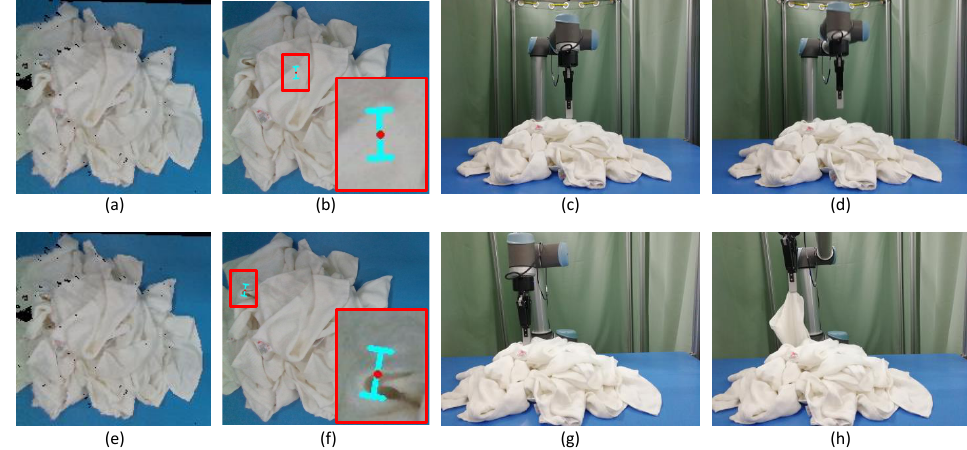
Figure 13. The comparison of the highest point and our method: ( a ) the point clouds of the white square towels on a table; ( b ) the projection of a grasp pose on the image with the highest point; ( c ) the robotic arm reaches the grasp position;( d ) the robotic arm picks empty; ( e ) the point clouds of the white square towels on a table; ( f ) the projection of the grasp pose on the image with our method; ( g ) the robotic arm reaches the grasp position; ( h ) the robotic arm picks a towel.